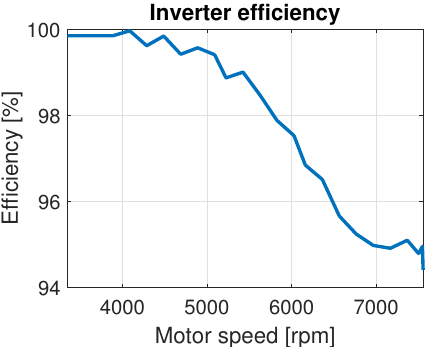
Figure 6. Efficiency curves for inverter electrical